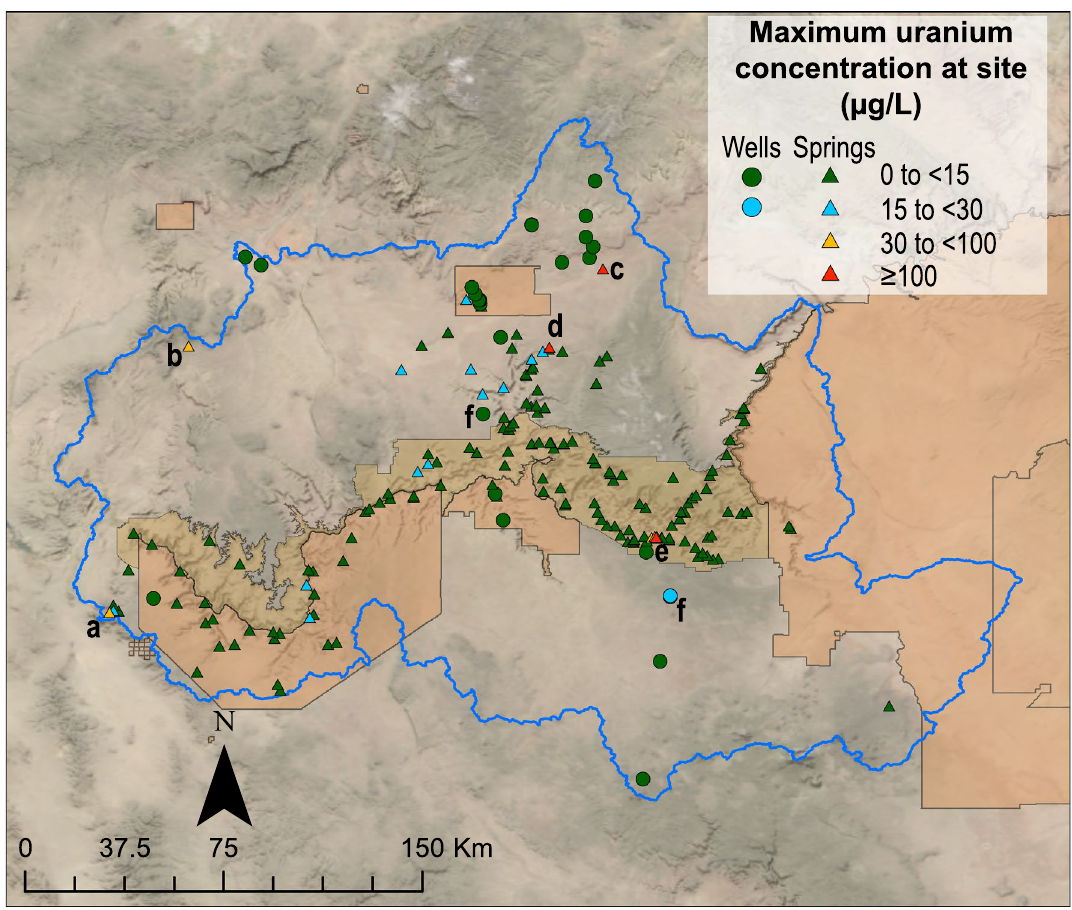
Figure 3. Map of maximum uranium concentration at 206 groundwater sites in the Grand Canyon region. Letters indicate sites that are discussed in the text. Map created in Esri ArcMap 10.8.1 (https:// www. esri. com/). Basemap images from the public domain USGS National Map 11